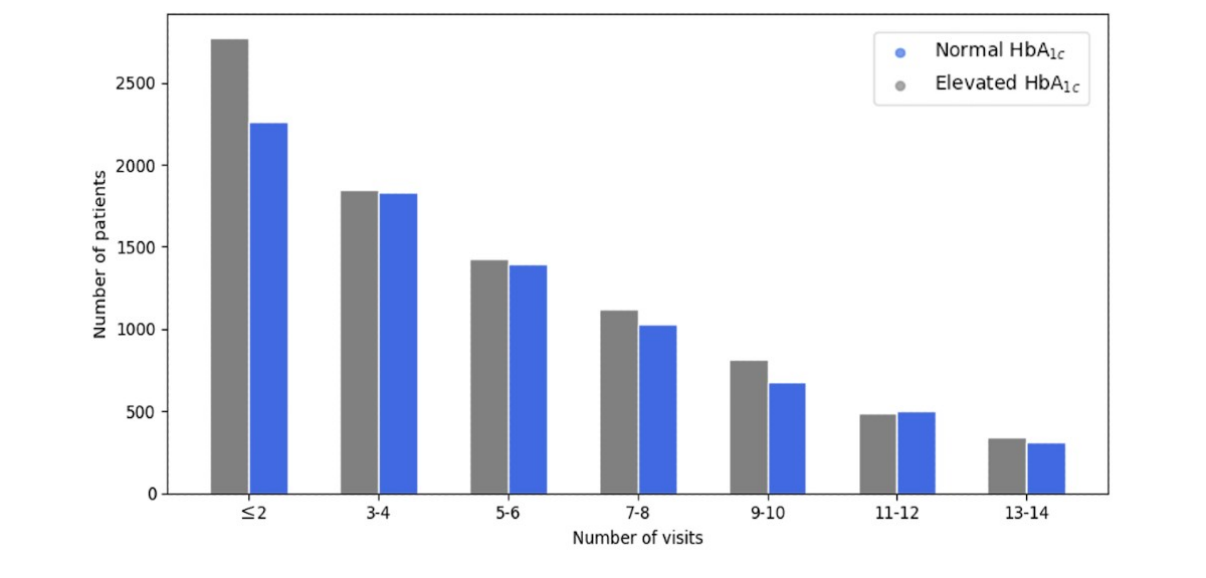
Figure 12. The details for the number of visits made over number of patients. HbA 1c : glycated